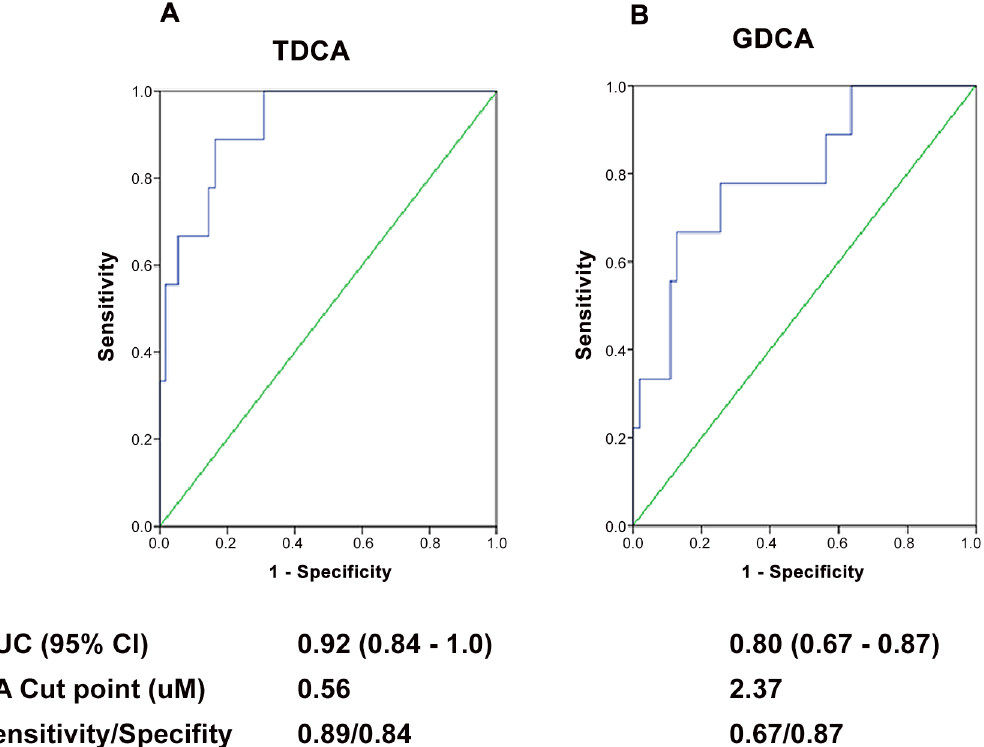
Fig 2. Receiver operator curve (ROC) analysis of bile acids (BA) that best distinguished subjects with acetaminophen protein adducts < 1 versus (cid:1) 1.0 nmol/mL. TDCA, Taurodeoxycholic acid; GCDA, Glycodeoxycholic acid.